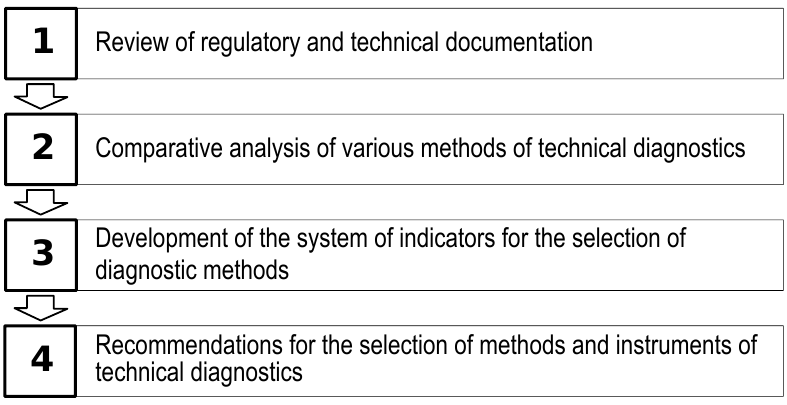
Figure 1. Scheme of the study that is presented in this article.